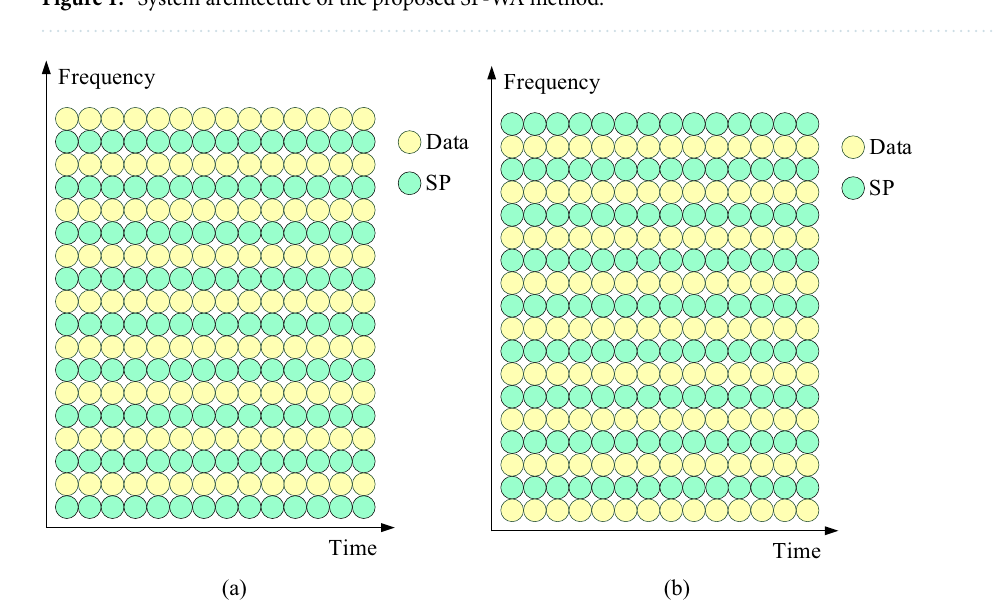
Figure 2. Superimposed pilot pattern in two signals: ( a ) the first signal and ( b ) the second